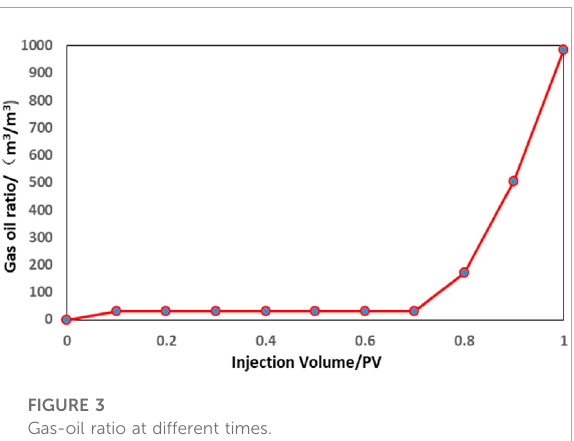
FIGURE 3 Gas-oil ratio at different